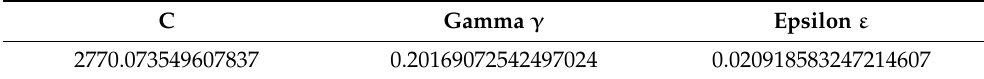
Table 3. SVR-hyperparameters.